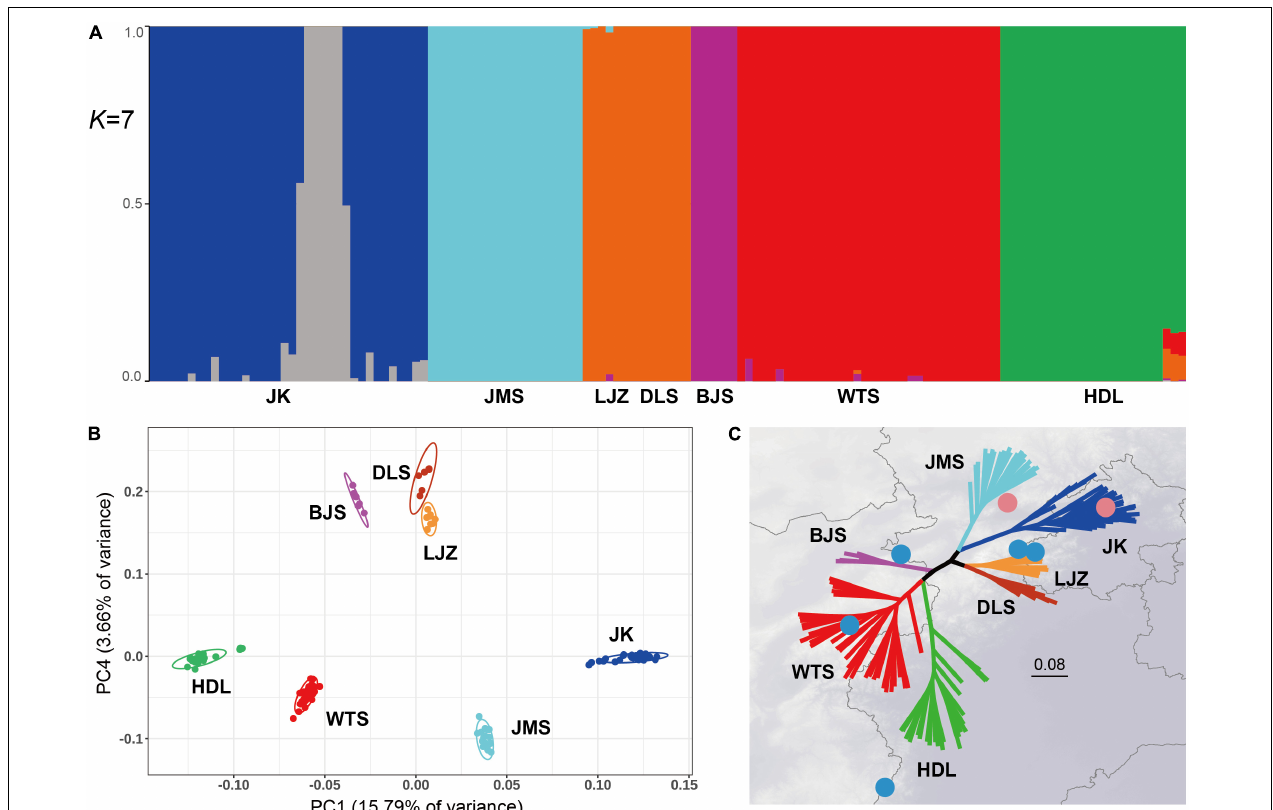
FIGURE 2 | Genetic structure and phylogenetic relationships of the seven Lonicera oblata populations. (A) Admixture proportions of genetic clusters for each individual of the seven populations. The scenario of K = 7 is the best value according to cross-validation analysis. (B) Principal component analysis plot for the 134 L. oblata individuals based on the first two principal components. (C) A maximum-likelihood tree based on 33,758 single-nucleotide polymorphisms (SNPs) of the nuclear genome, with seven fully supported lineages (ML BS = 100), which exactly correspond to species’ natural populations. The two pink circles on the northside represent populations from Yan Mountains, and the five blue circles represent populations from Taihang